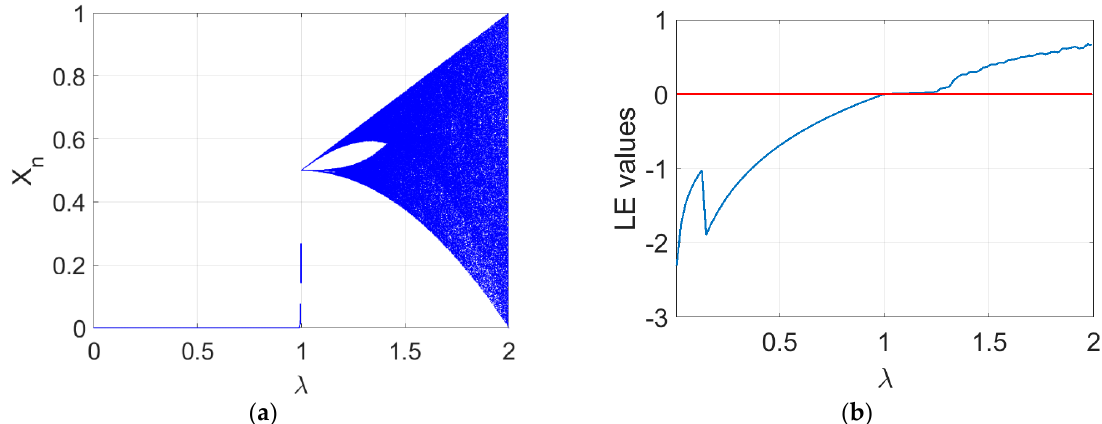
Figure 1. ( a ) Bifurcation diagram and ( b ) LE of TM for λ ∈ [ 0,2 ] with T